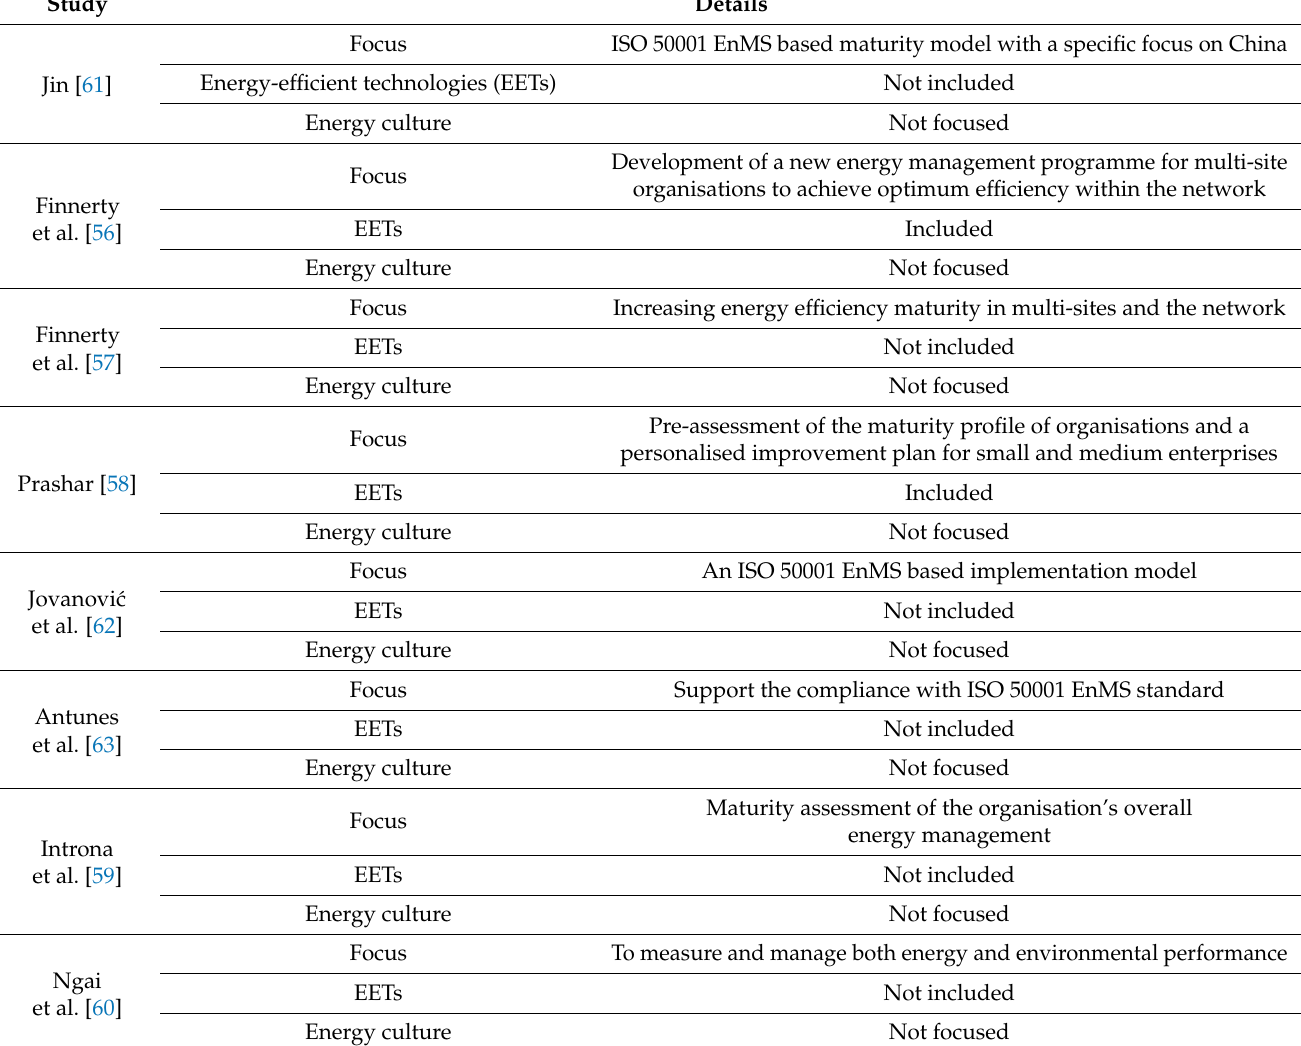
Table 1. Review on energy maturity